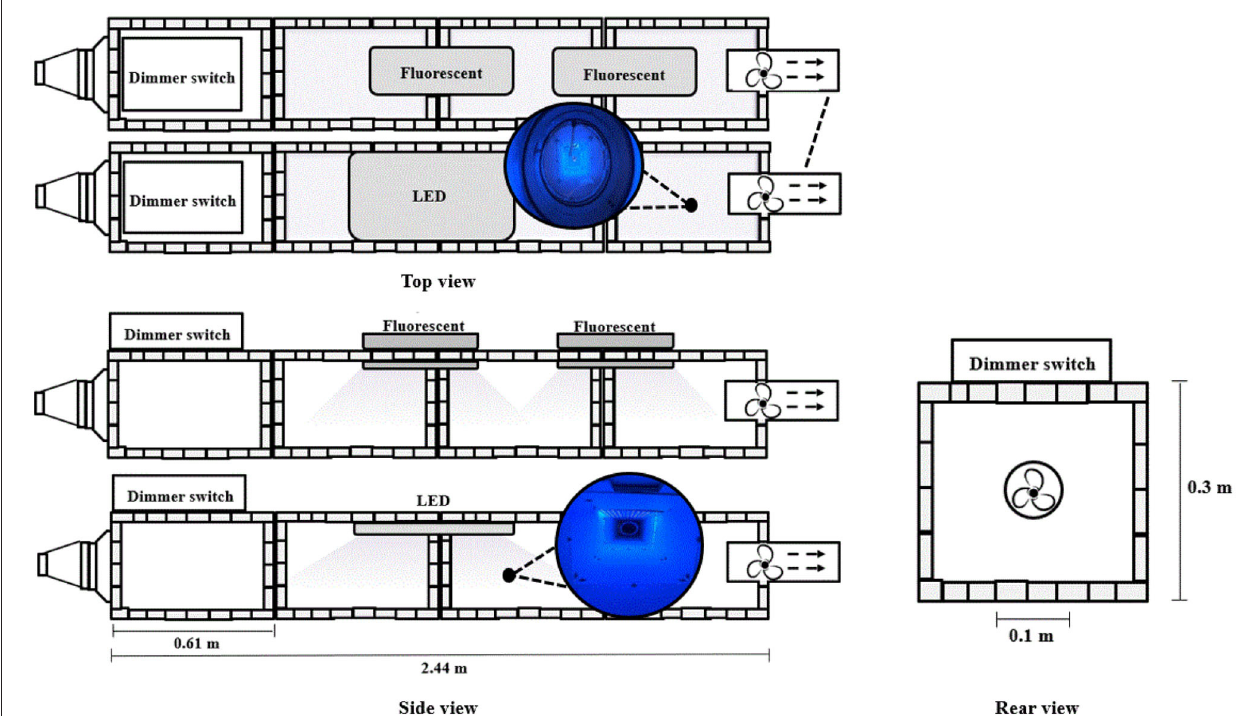
FIGURE 1 | Schematic of pilot-scale UV reactor for mitigation of selected gases inside a poultry barn.